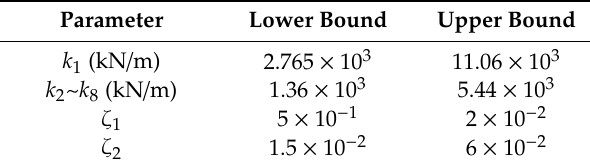
Table 2. Bounds of the prior uniform parameter distributions.